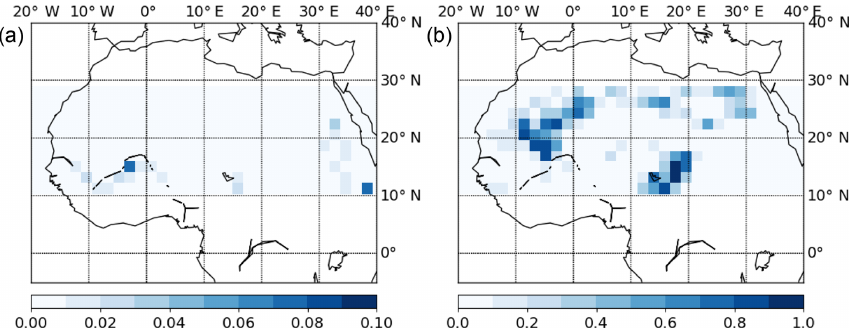
Figure 1. Preindustrial lake distribution based on satellite data (Hagemann, 2002) (a) and a paleolake reconstruction of Tegen et al. (2002) (b) . The color indicates the lake fraction in a grid cell. Note that the scales are different.